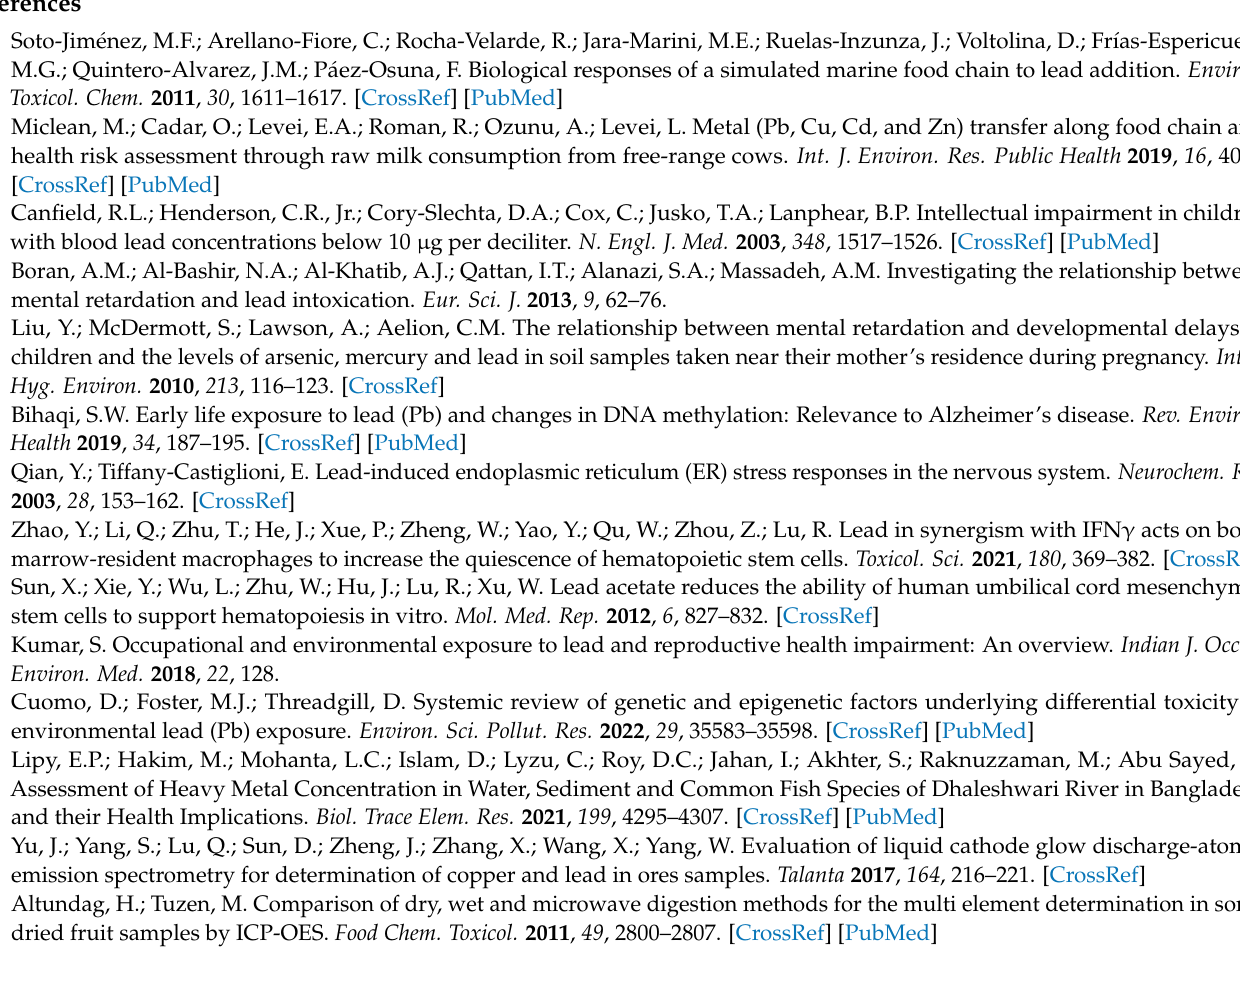
KCl; Table S1: Comparison of analytical response of biological devices in Pb(II) detection with other reported analytical methods. References [35–38] are cited in the supplementary